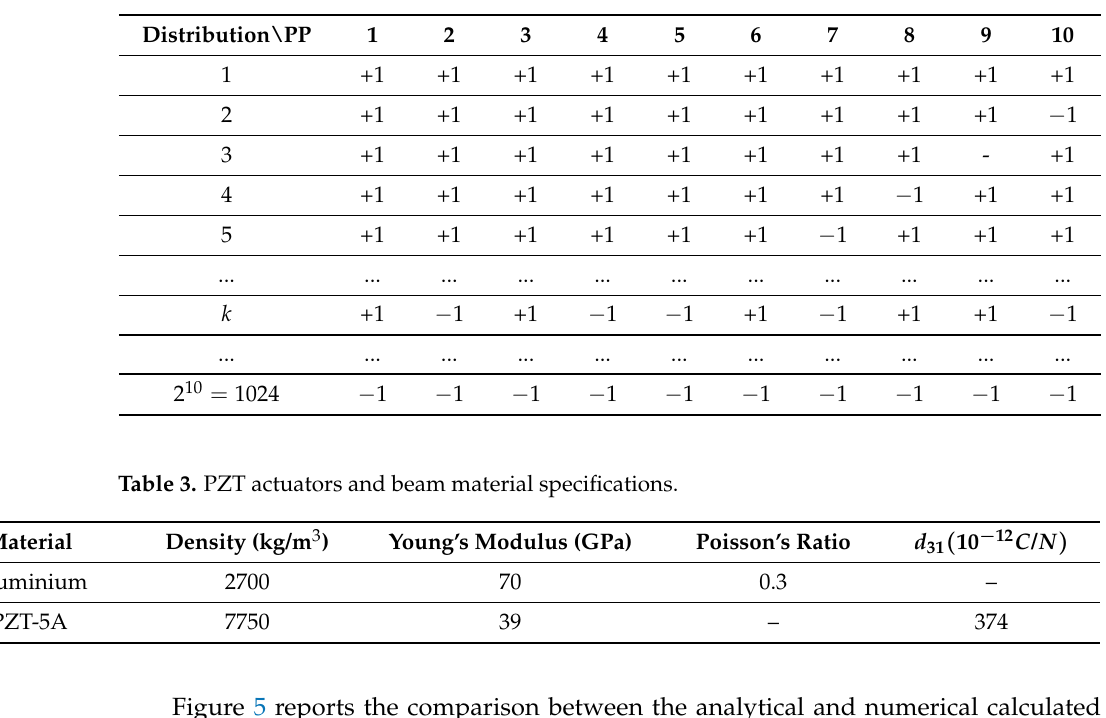
Table 2. Possible voltage distributions.